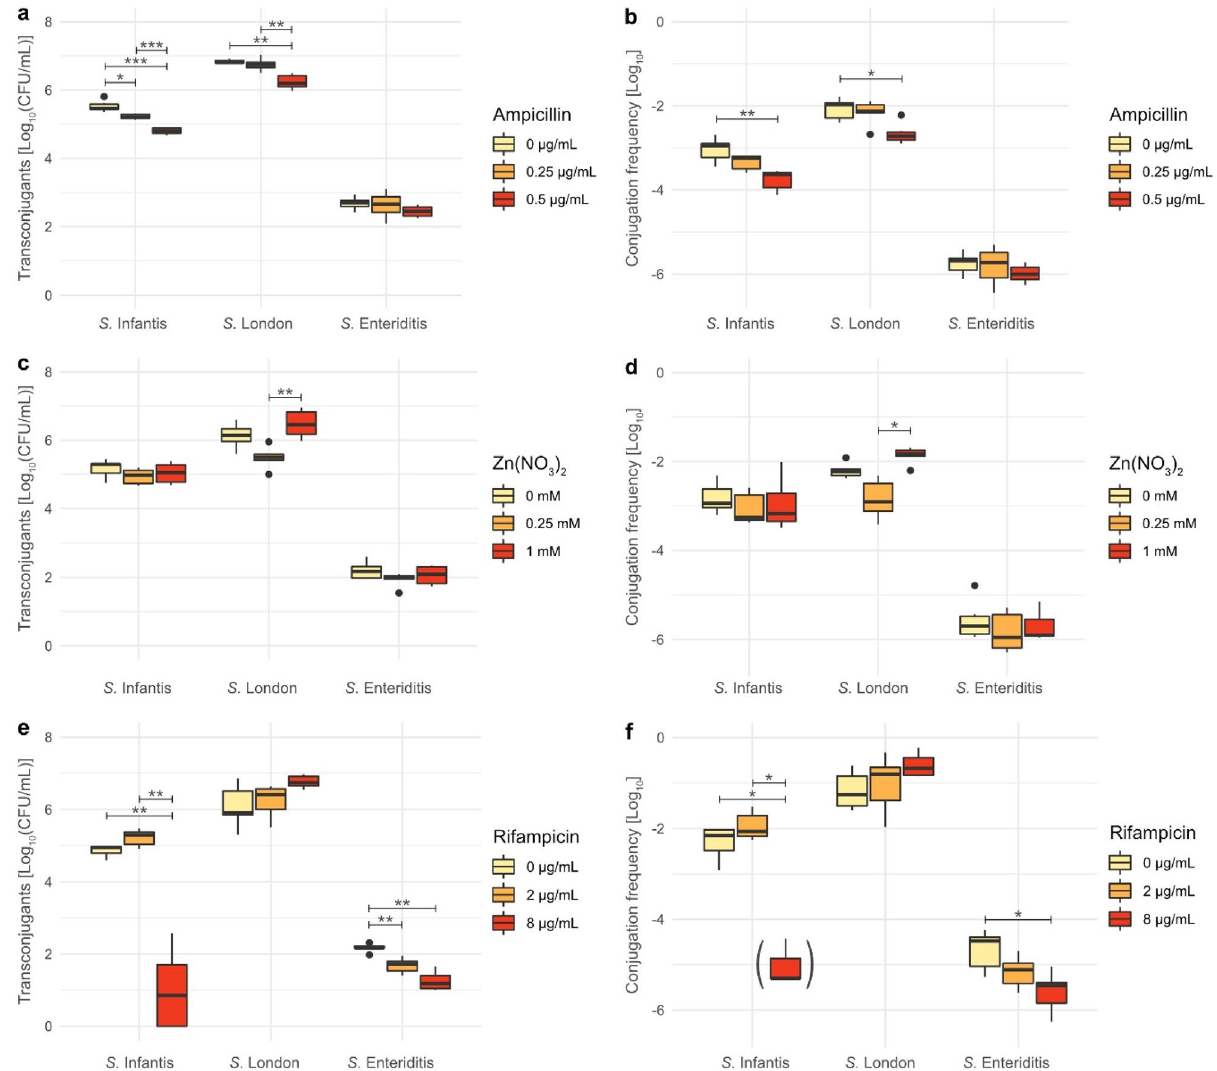
Figure 1. Transconjugant numbers and calculated conjugation frequencies, observed at different concentrations of ampicillin ( a , b ), Zn(NO 3 ) 2 ( c , d ), and rifampicin ( e , f ). Pairwise comparison of transconjugant numbers and conjugation frequencies at different concentrations was perform via the Student’s T -test. P -values were adjusted using the Bonferroni correction. Significance levels: * p < 0.05, ** p < 0.01, *** p < 0.001. Boxplot in brackets ( f ) indicates that the calculation of conjugation frequencies for some data points was omitted due to no observed